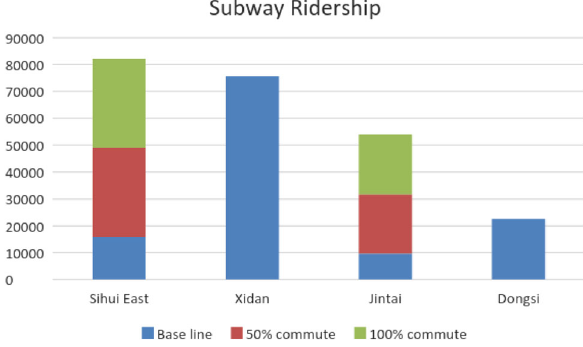
Fig. 2 Ridership comparison (Sihui East and Xidan on Line 1 ; Jintai and Dongsi on Line 6